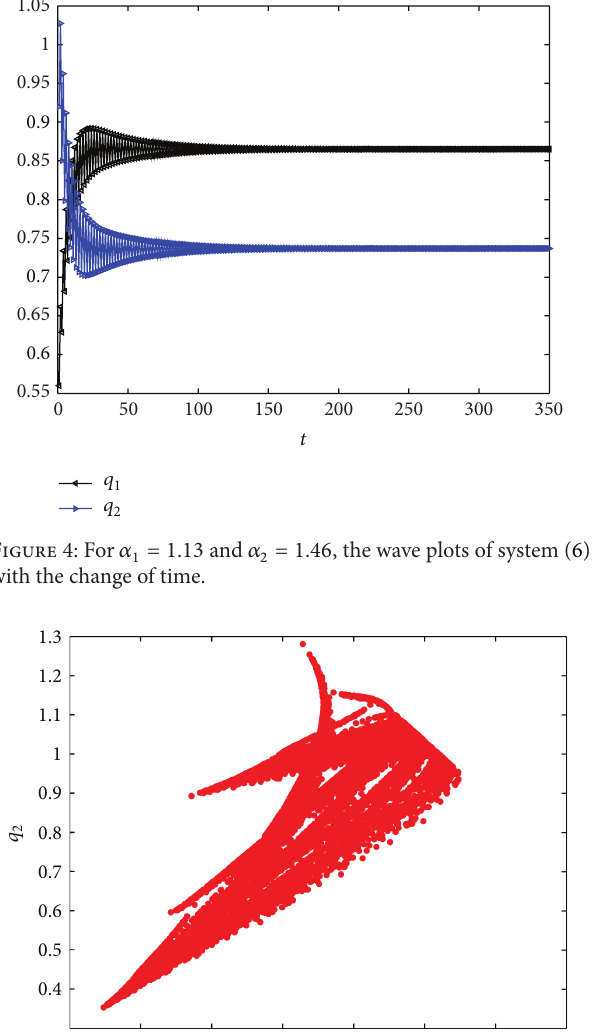
Figure 7: The corresponding Lyapunov exponents diagram with ∈ (0.5,2.51538] and 𝛼 = 1.32 . 𝛼 2 1